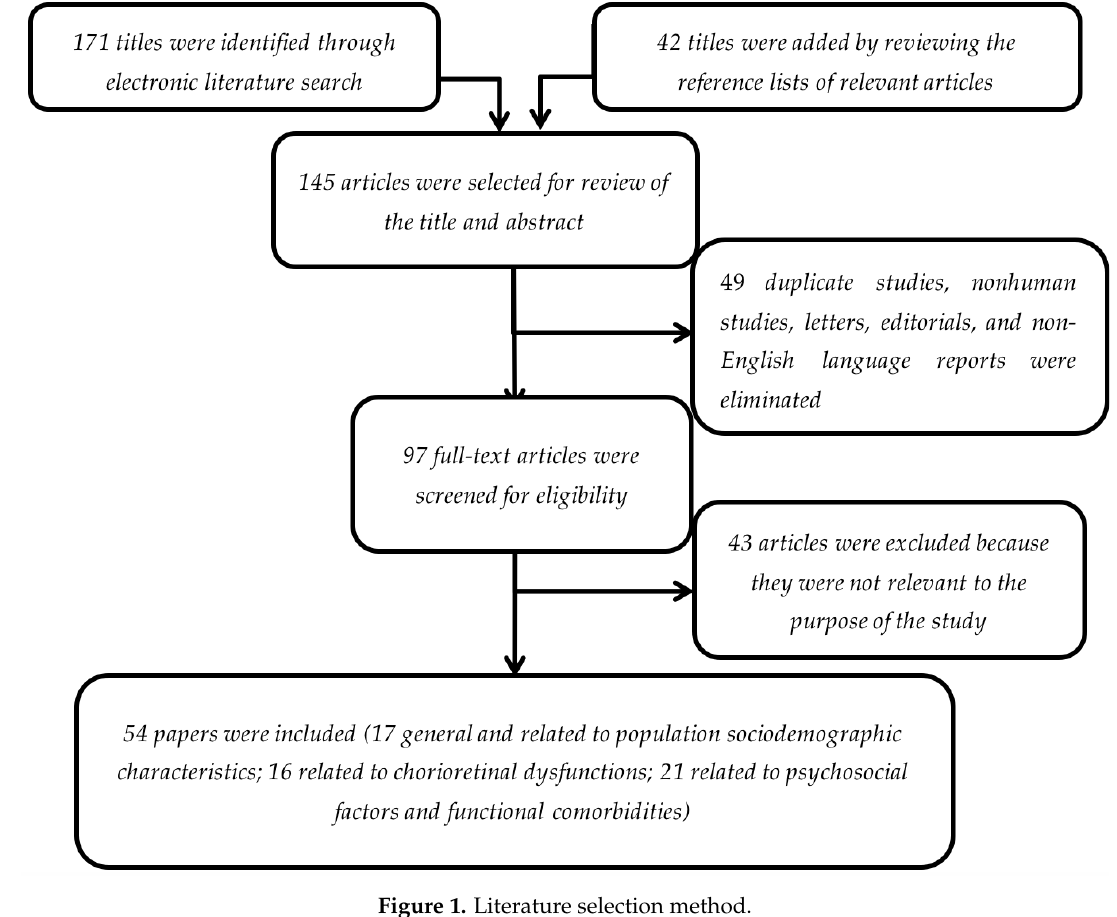
Figure 1. Literature selection method.